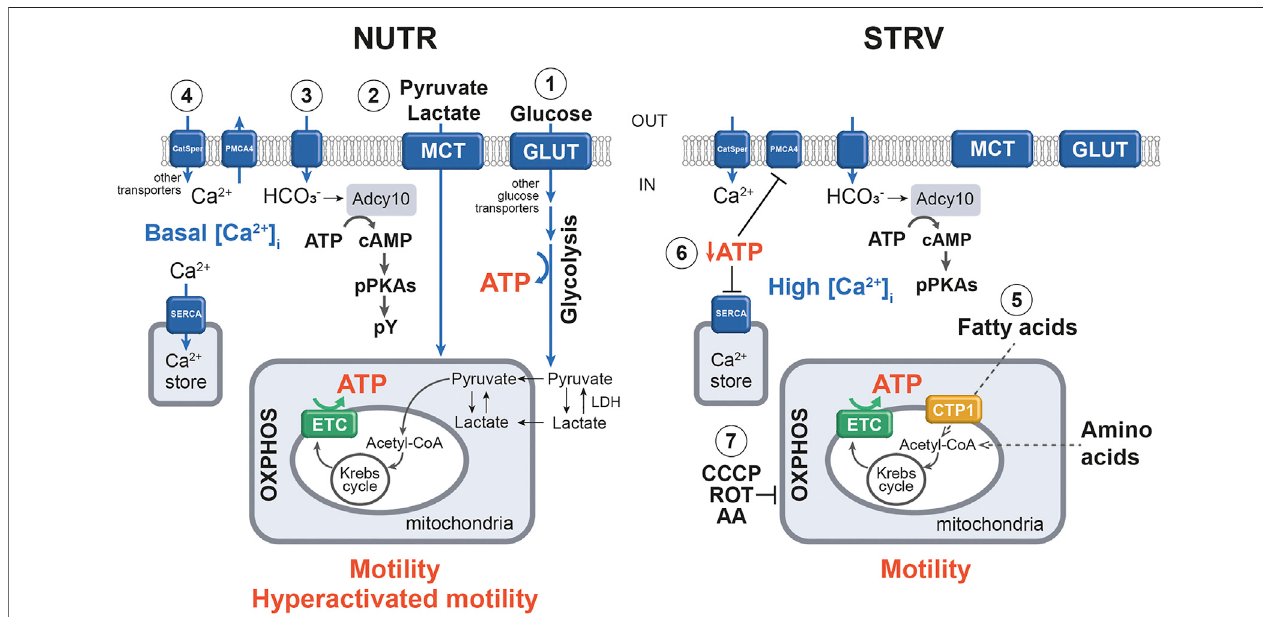
FIGURE 7 | Simpli fi ed model of the molecular mechanisms underlying sperm incubation in the presence and absence of exogenous nutrients. 1) In NUTR condition, glucose is transported into sperm through GLUT and other active transporters, and enters the glycolytic pathway, producing ATP. The fi nal product of glycolysis is pyruvate, which can be converted to lactate by LDH. 2) Exogenous pyruvate and lactate can also enter sperm plasma membrane by MCT and be transportedtothemitochondriaforfurthermetabolizationbytheKrebscycleandOXPHOS,whichalsogenerateATP.3)In fl uxofHCO 3 − stimulatesAdcy10withthe productionofcAMPandactivationofPKA,whichinturn,provokesthephosphorylationofsubstrates.4)Underthiscondition,Ca 2+ entersspermmainlythroughCatSper channels and [Ca 2+ ] i levels are regulated by ATP-driven pumps (PMCA4 and SERCA). As a result, sperm can maintain motility and develop hyperactivation. 5) In the absenceofexogenoussubstrates,ATPwould beproduced byfattyacidoxidation and/or byaminoacidmetabolism.Such ATPallowstheproduction ofsuf fi cientlevels ofcAMPtostimulatepPKAs.6)DecreasedATPconcentrationsinhibitthenormaloperationofCa 2+ pumpsandtransporters,increasingthe[Ca 2+ ] i .Alltheseeventsallow the development of motility but not hyperactivation. 7) In STRV, the addition of CCCP, ROT and AA blocks OXPHOS, resulting in motility loss. To simplify this model, transportersandsomeenzymesarenamedbygenericterms.Filledarrowsindicateactivation;dottedarrowsshowhypotheticpathways.NUTR,mediumsupplemented with glucose, pyruvate and lactate; GLUT, glucose transporter; LDH, lactate dehydrogenase; MCT, monocarboxylate transporter; PMCA4, plasma membrane Calcium ATPase 4; SERCA, sarcoplasmic/endoplasmic reticulum Ca 2+ ATPases; Acetyl-CoA, acetyl coenzyme A; OXPHOS, oxidative phosphorylation; ETC, mitochondrial electron transport chain; Adcy10, atypical soluble adenylyl cyclase; PKA, protein kinase A; pPKAs, phosphorylation in PKA substrates; pY, phosphorylation on tyrosine residues; STRV, starving conditions; CTP1, carnitine palmitoyl transferase I; CCCP, carbonyl cyanide p -chlorophenylhydrazone (a mitochondrial uncoupler); ROT, rotenone (inhibitor of ETC complex I); AA, antimycin A (inhibitor of ETC complex III).